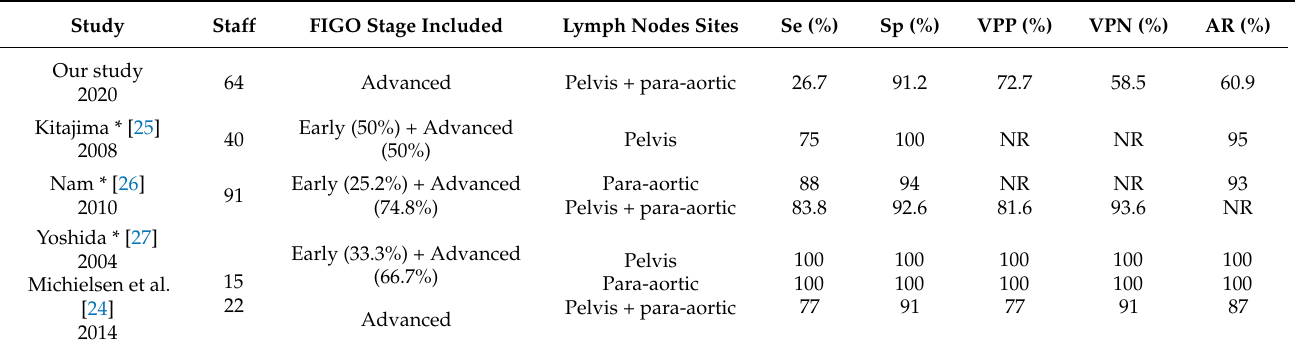
Table 4. Summary of the various data in the literature regarding nodal positron emission tomography/computed tomogra- phy (PET-CT) evaluation for advanced epithelial ovarian, fallopian tubal, or peritoneal cancer (EOC).